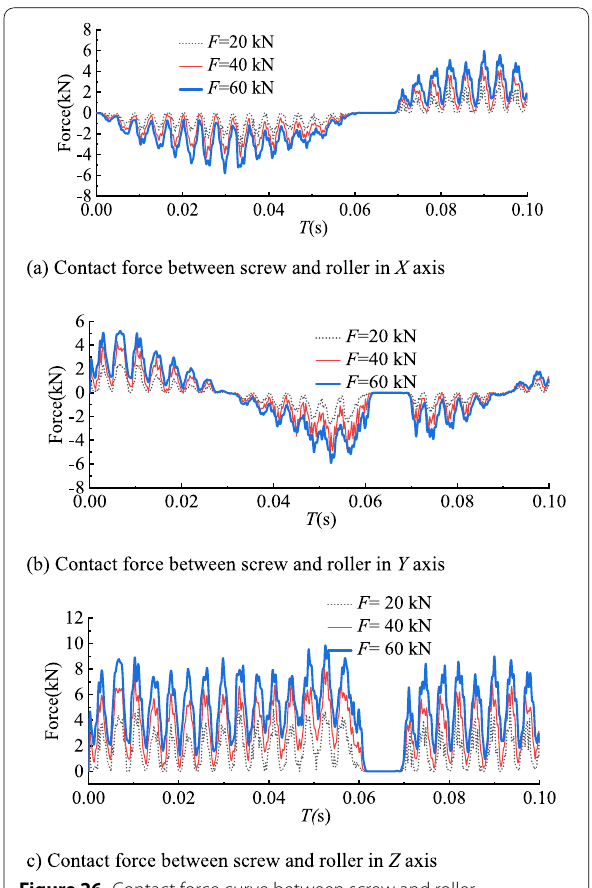
Figure 26 Contact force curve between screw and roller